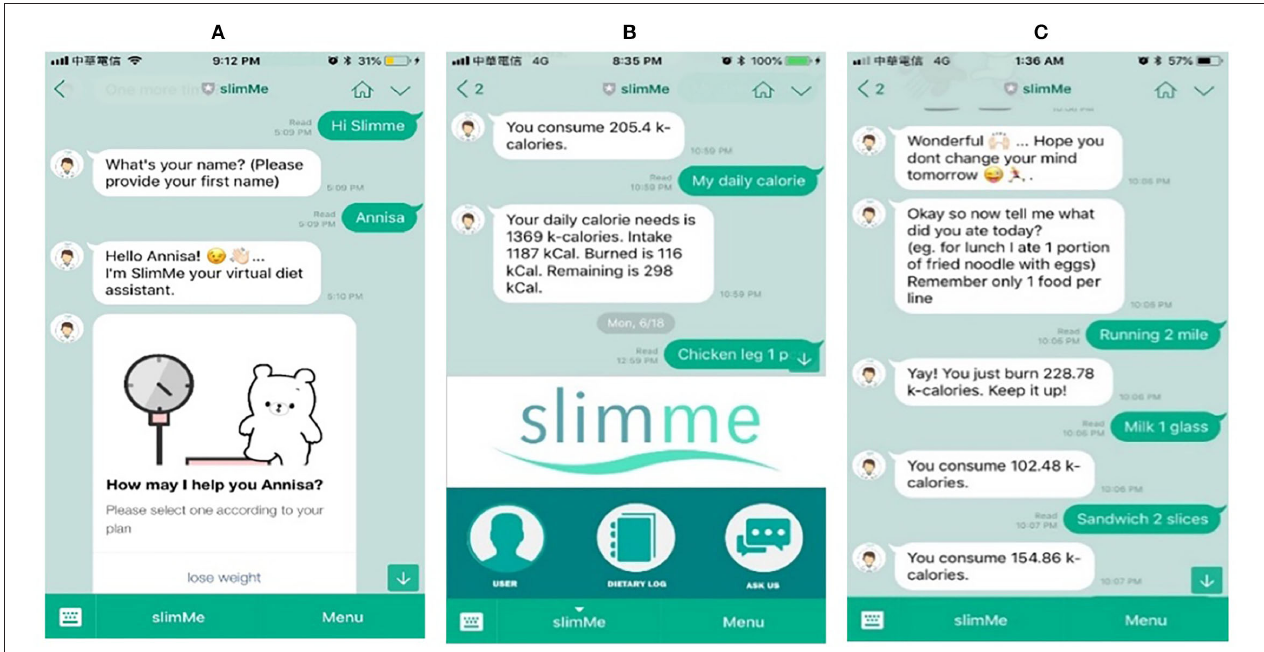
FIGURE 3 | SlimMe design interface using LINE messenger platform. (A) Greeting to start the nutrition assessment. (B) Daily calorie record. (C) Calorie intake and exercise